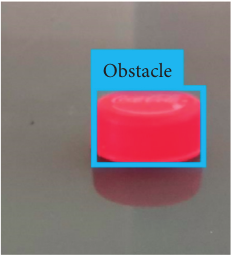
Figure 17: Detection result of bottle cap.